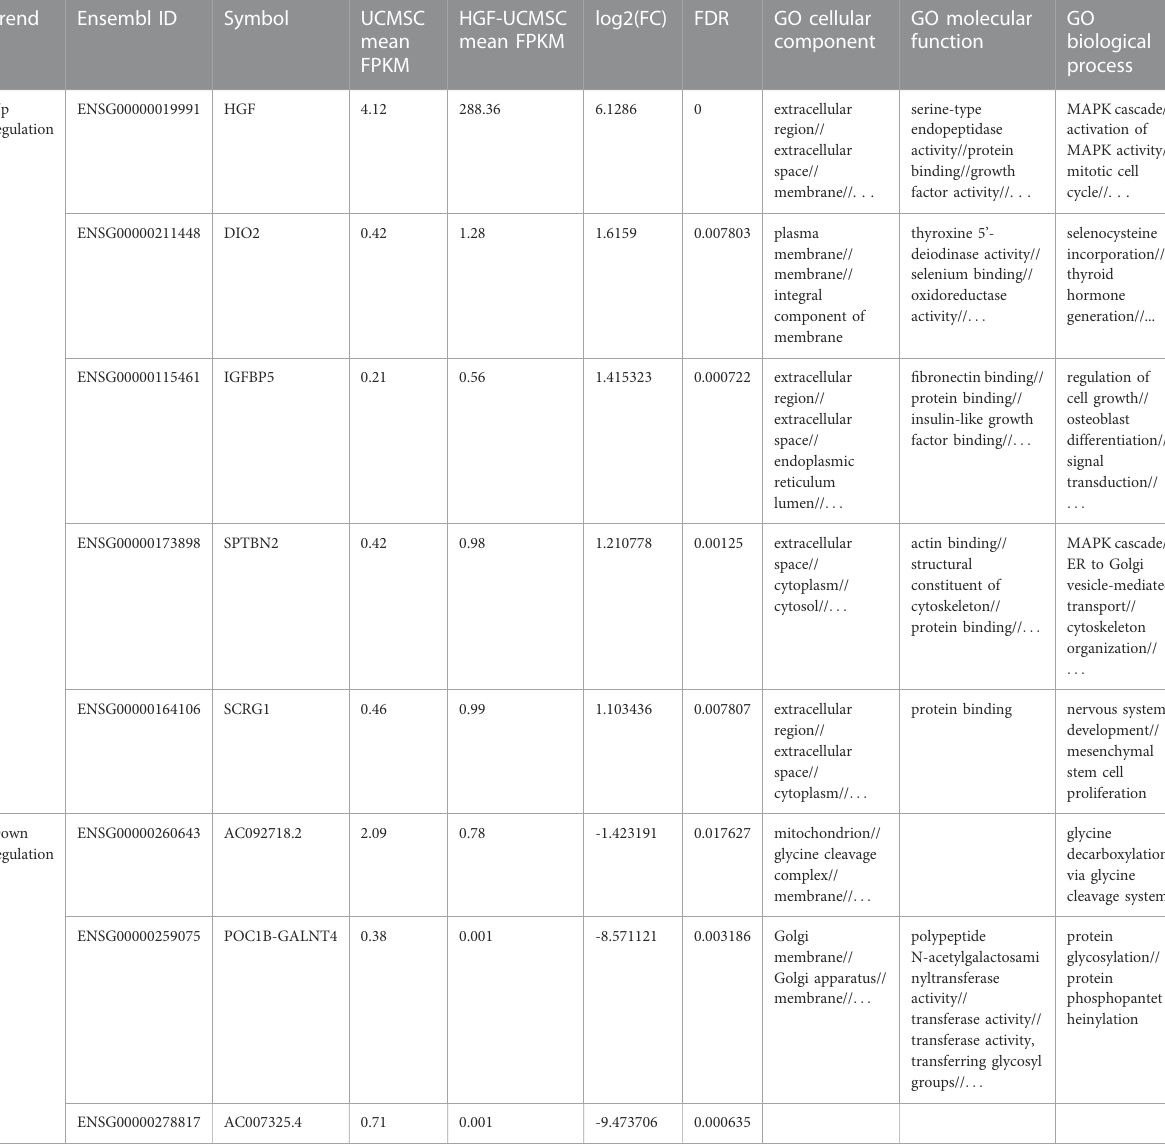
TABLE 1 Statistics for signi fi cant differential genes. Trend Ensembl